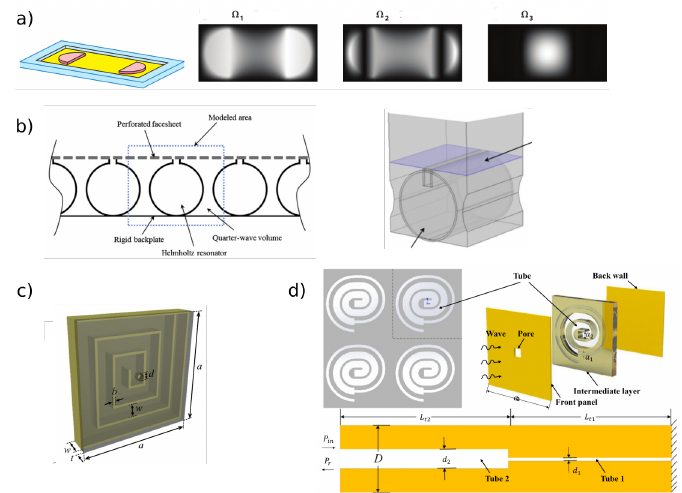
Figure 3. Various metamaterial designs for low-frequency absorption: ( a ) a membrane decorated with added platelets and displacement related to the first three eigenfrequencies of the structure from [47]; ( b ) a dual resonant metamaterial composed of Helmholtz’s resonators, and a perforated sheet adopted as an innovative liner in [43]; ( c , d ) two different space-coiling designs, respectively from [45] and [46]. The dissipation of acoustic energy is fundamental in each design.